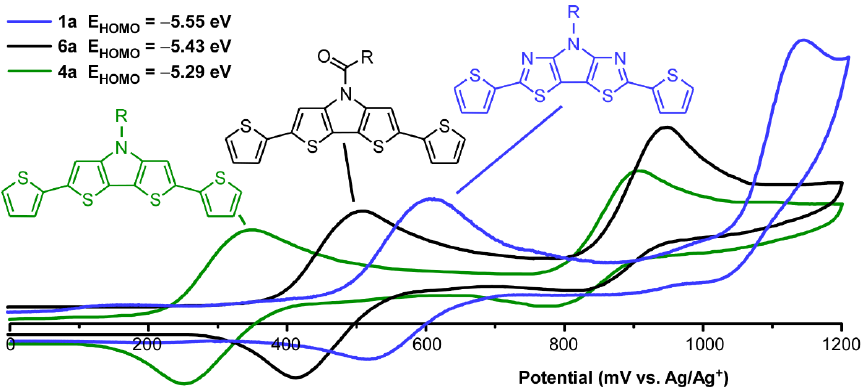
Figure 7. Cyclic voltammograms comparing DTP and PBTz oligomers 1a , 4a , and 6a .